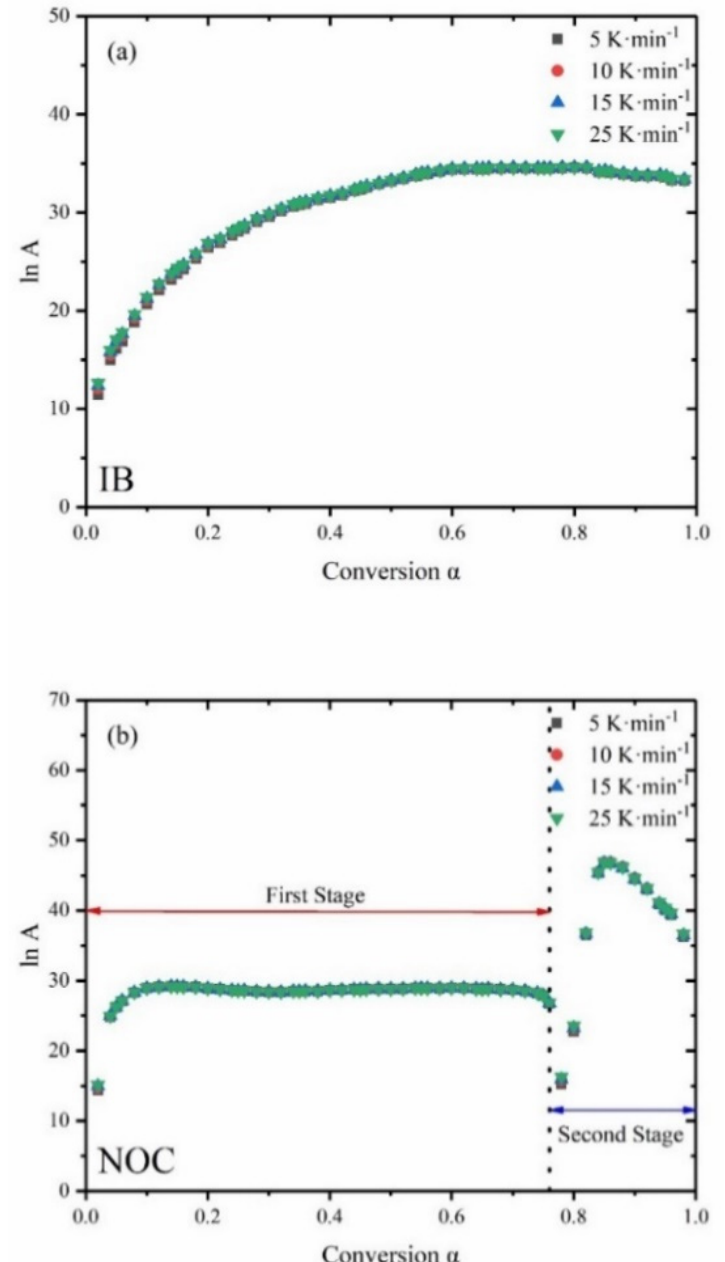
Figure 6. Dependence of pre-exponential factors on conversional extent at different heating rates: ( a ) IB, ( b ) NOC.